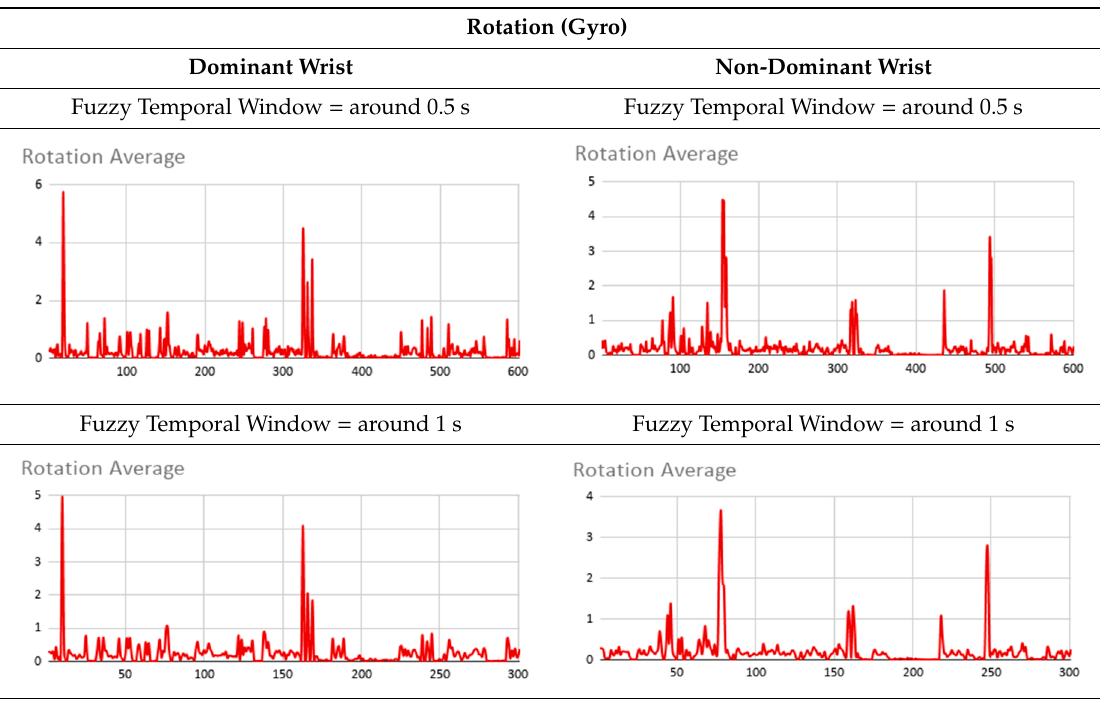
Table 5. Rotation (Gyro) results with different fuzzy temporal windows from both wrists.